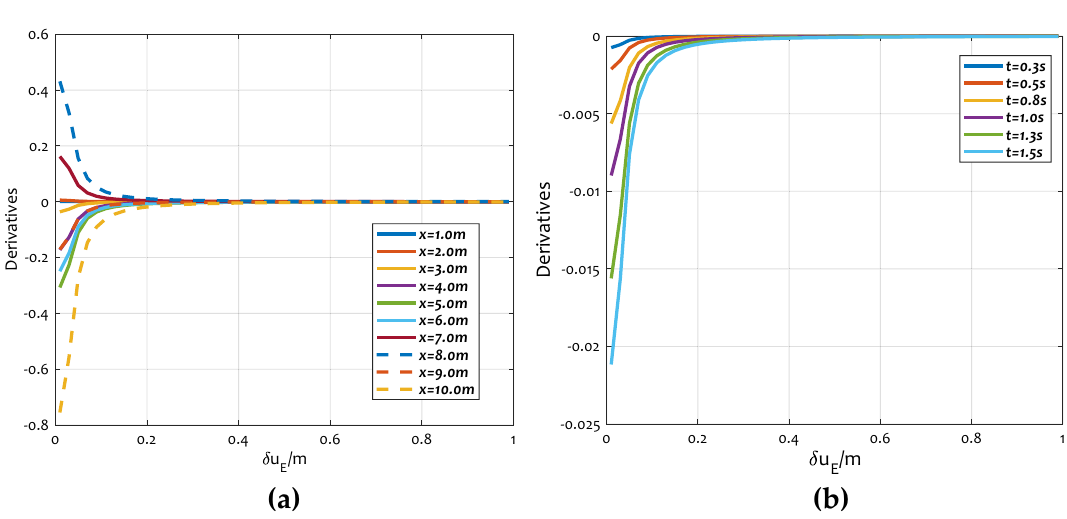
Figure 11. Correlation analysis between d χ and δ u : ( a ) d χ to δ u curves of different position; ( b ) d χ to δ u curves of different